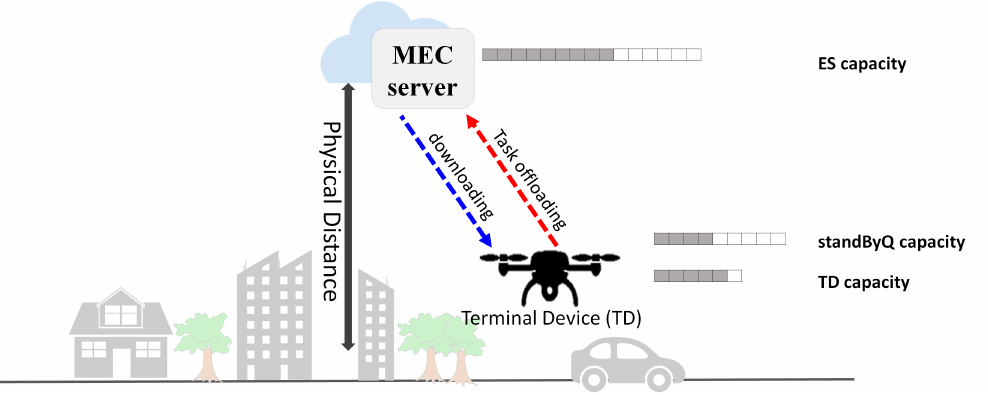
Figure 2. Reference system